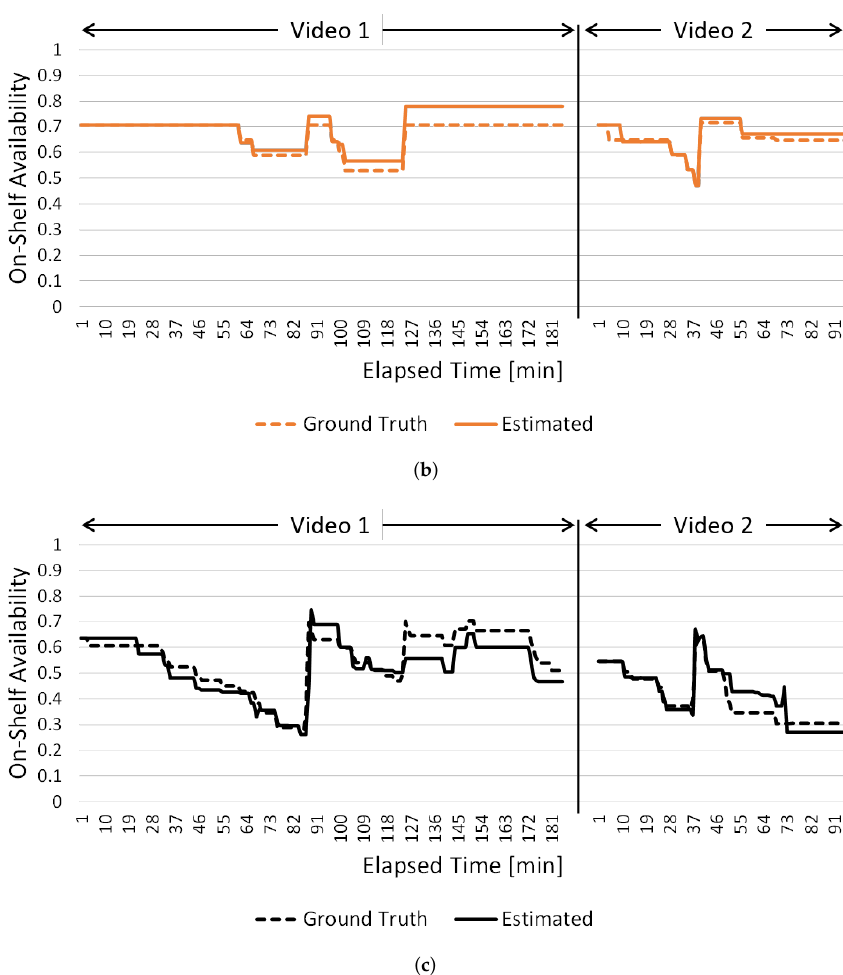
Figure 15. Changes in on-shelf availability every minute in cases of high success rates. ( a ) Results for shelf #3. ( b ) Results for shelf #7. ( c ) Results for shelf #17.